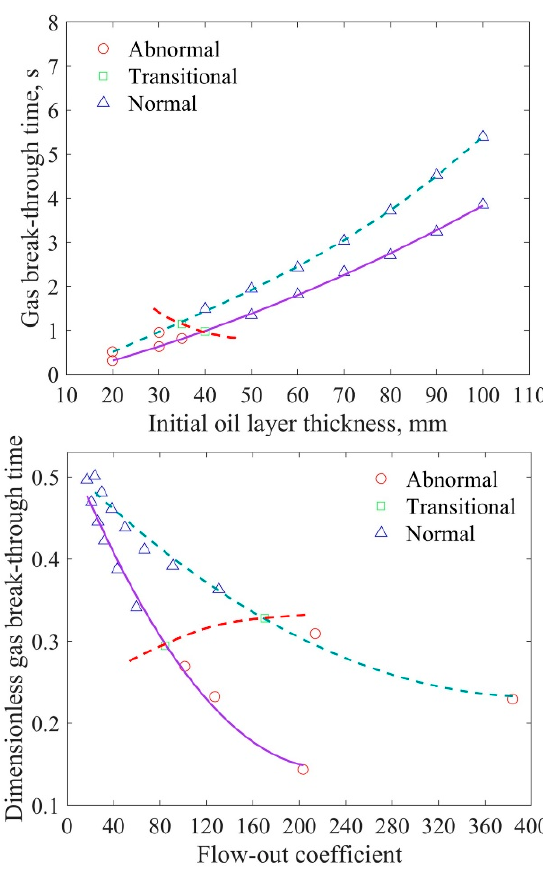
Figure 14. Effect of oil viscosity on the drainage end state. Initial l–l interface level: 10 mm, pressure difference: 0.3 bar, oil viscosity: 0.131 Pa·s (solid line), 0.254 Pa·s (dashed line).